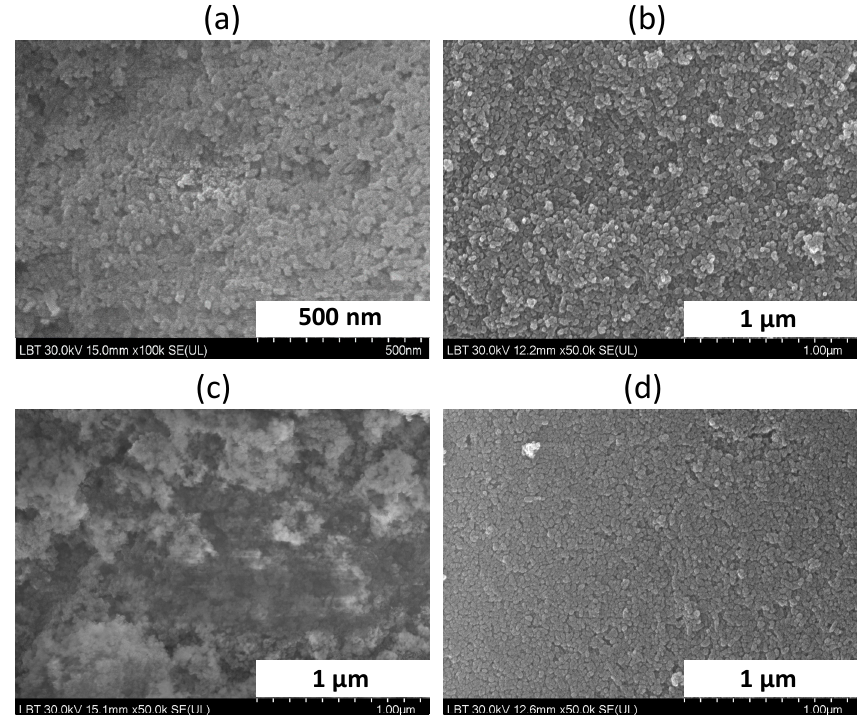
Figure 4. SEM images for ( a ) HAP, ( b ) HAP_4AP_25, ( c ) Si–HAP, and ( d ) Si–HAP_4AP_25, respectively.